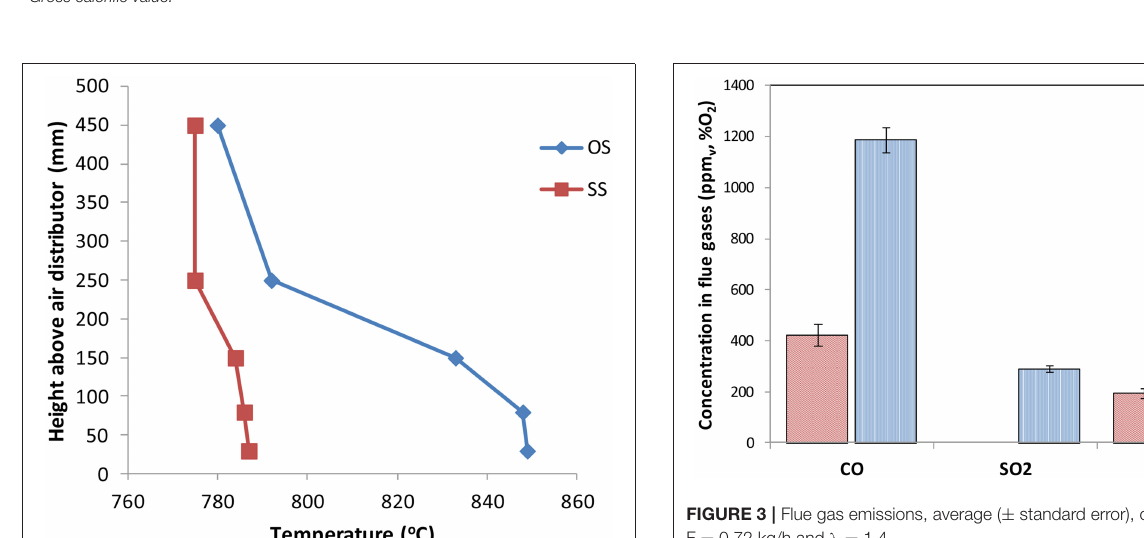
Present results are expected to be useful for future application of these waste materials in local thermal processes.